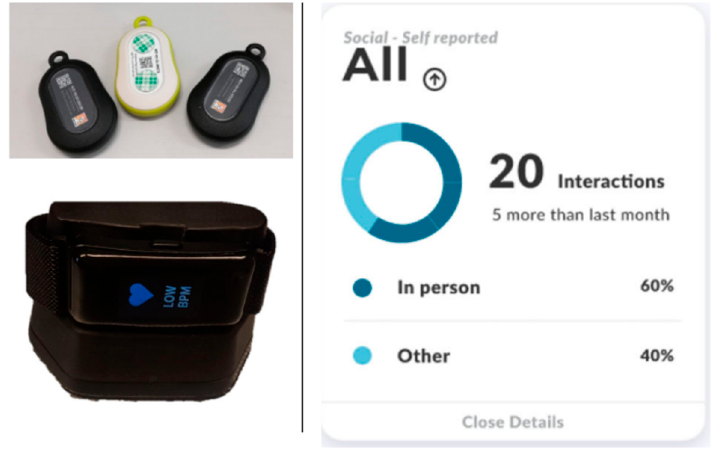
Figure 8. ( right ) The Bluetooth tags and the NESTORE wristband. ( left ) Detail of the computed